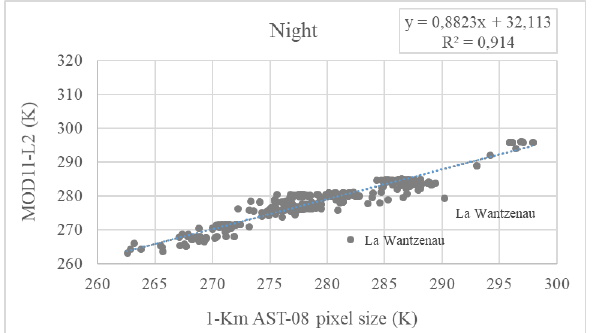
Figure 7. Correlation between 1km AST-08 pixel size and MOD11-L2 original pixel size.